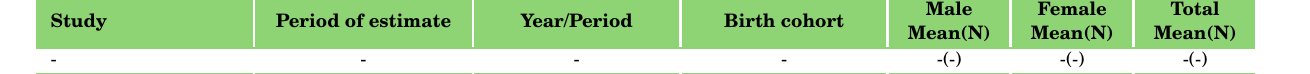
Table 43: Average number of sexual partners in